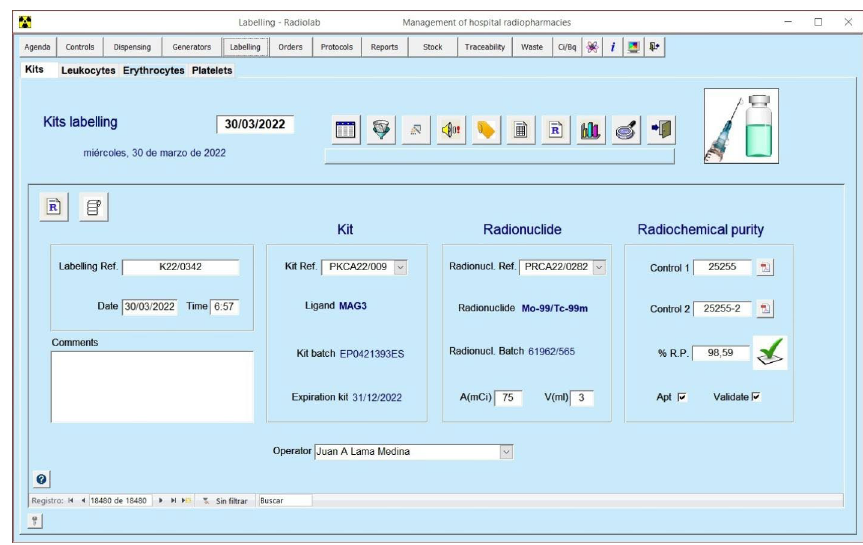
Fig. 5 Labelling module